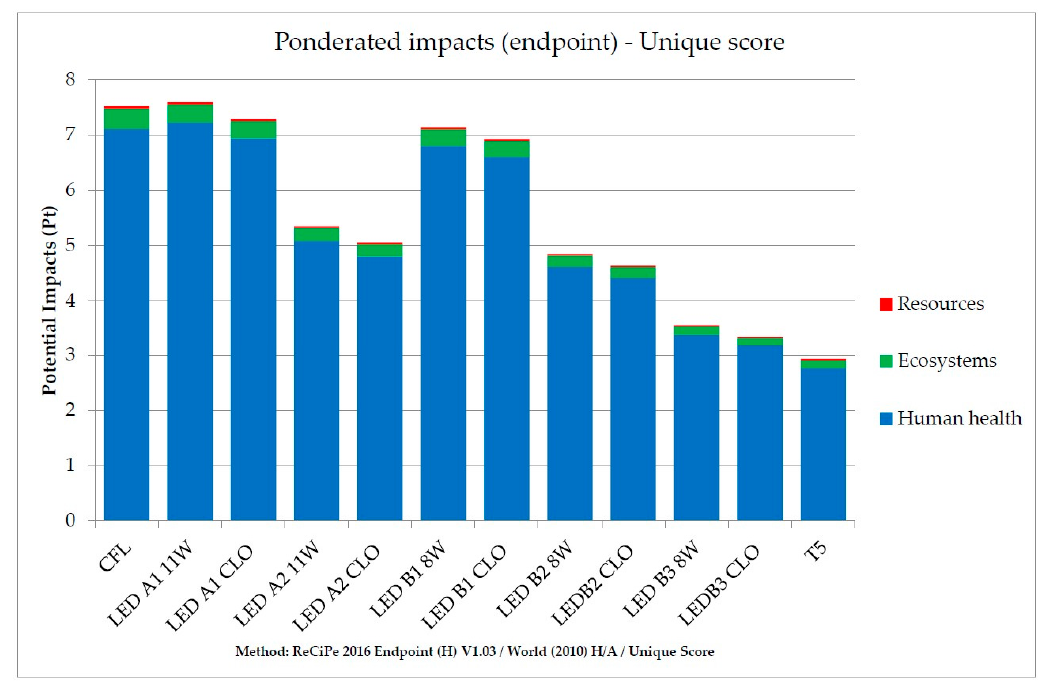
Figure 9. Endpoint potential impacts of LEDs with and without CLO.